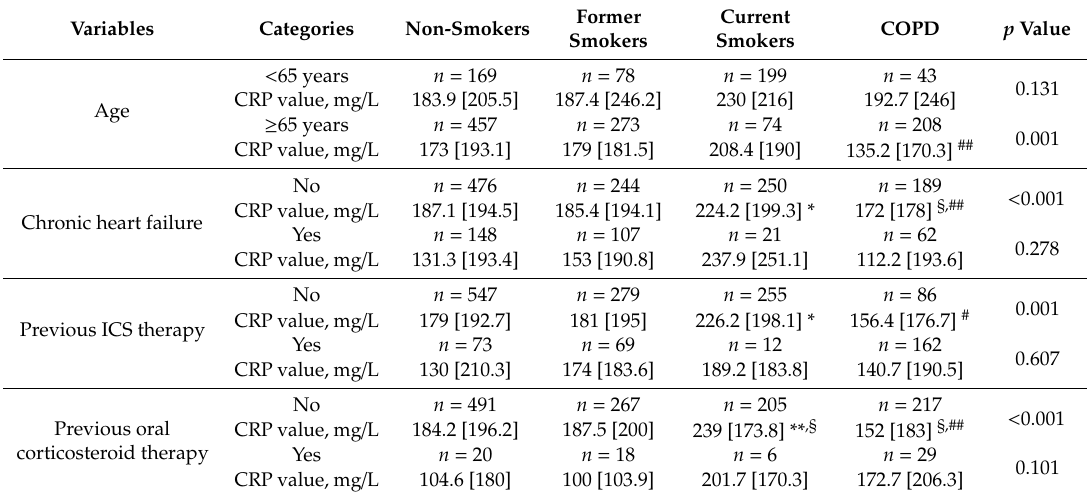
Table 4. Inflammatory response by smoking habit and COPD diagnosis for the main variables.